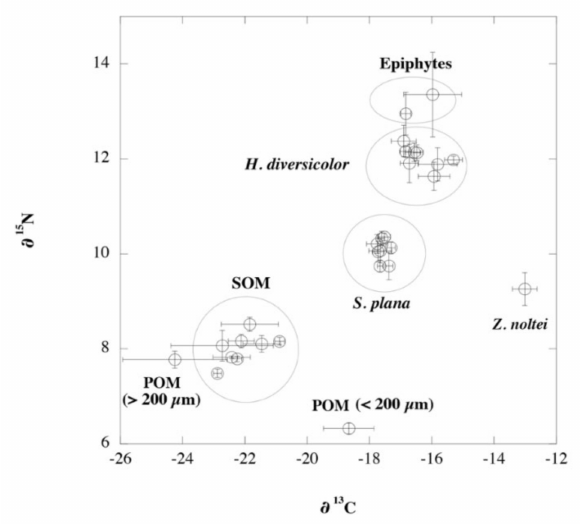
Figure 7. Isotopic signature ( δ 15 N and δ 13 C) of Scrobicularia plana and Hediste diversicolor and for the main likely food sources for these organisms collected in the different treatments (BS, ZNAP, CNAP, and ZNNP): Z. noltei, Zostera noltei leaves; Epiphytes, epiphytes attached to the mimics; SOM, sediment organic matter; and POM, fractionated particulate organic matter from the water column (i.e., higher or lower to 200 µ m). Data are represented as mean ± SE.